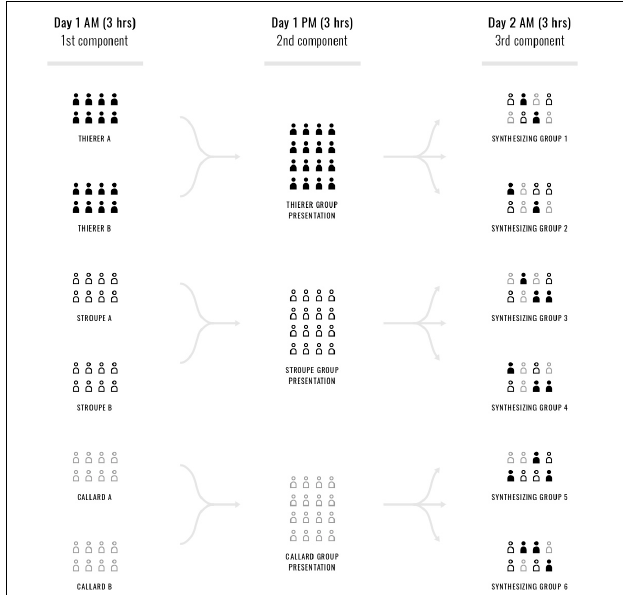
FIGURE 2 | Design charrette jigsaw analysis